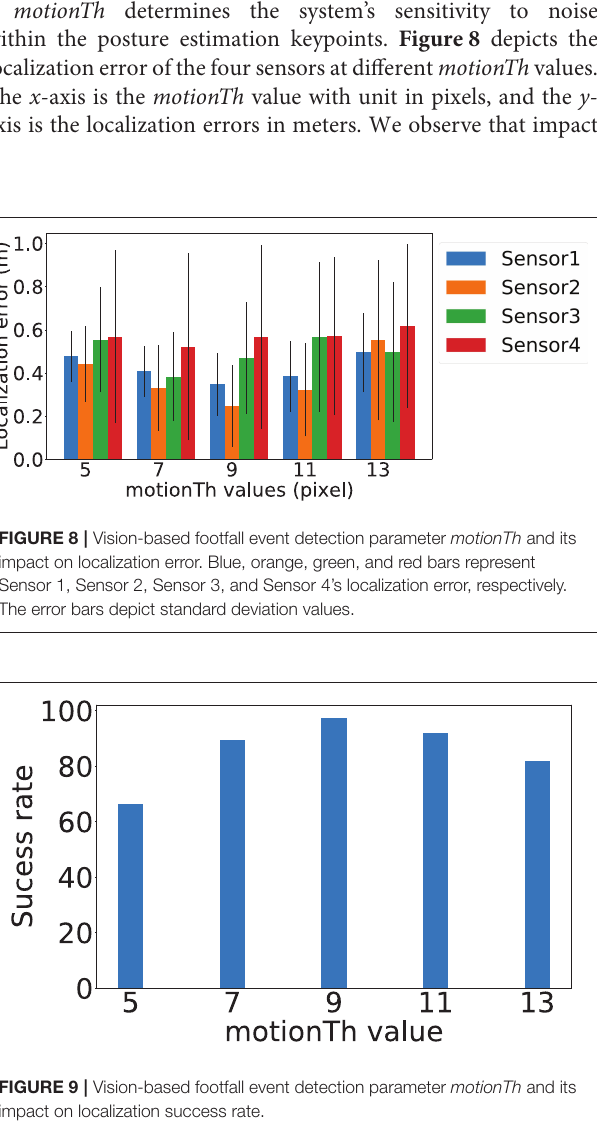
Frontiers in Big Data |